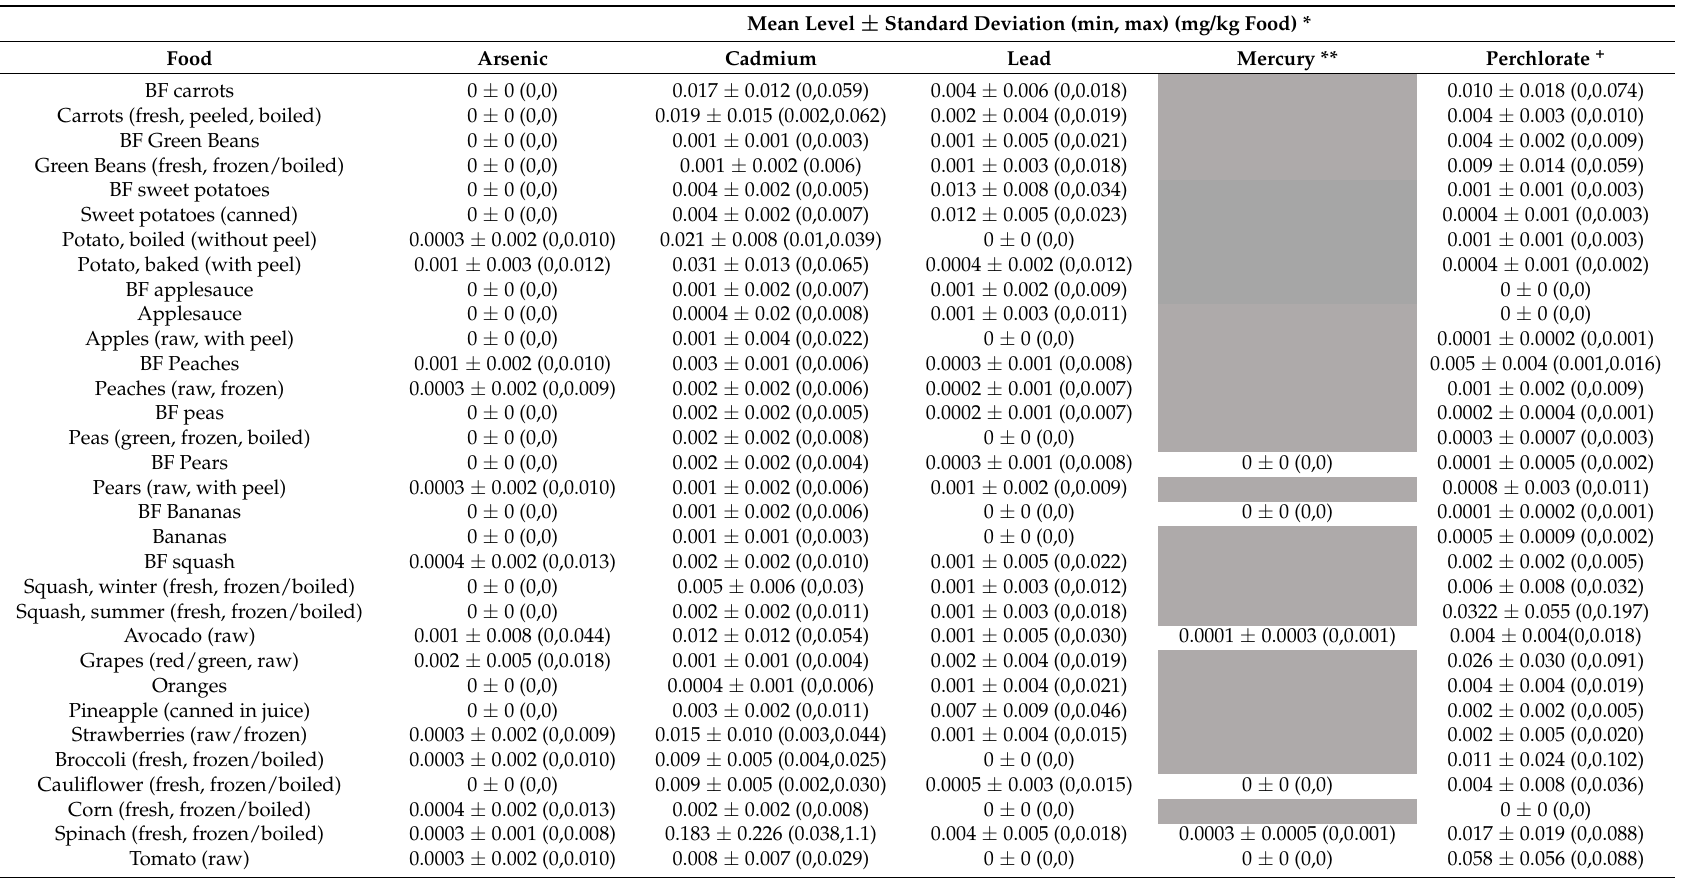
Table 4. Summary of US FDA Total Diet Study Results for Arsenic, Cadmium, Lead, Mercury and Perchlorate in Select Fruits and Vegetables